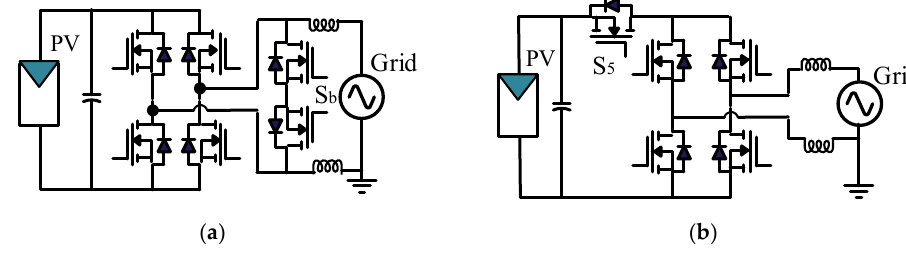
Figure 1. Conventional grid-connected PV inverters ( a ) HERIC [15] ( b ) H5 [16].